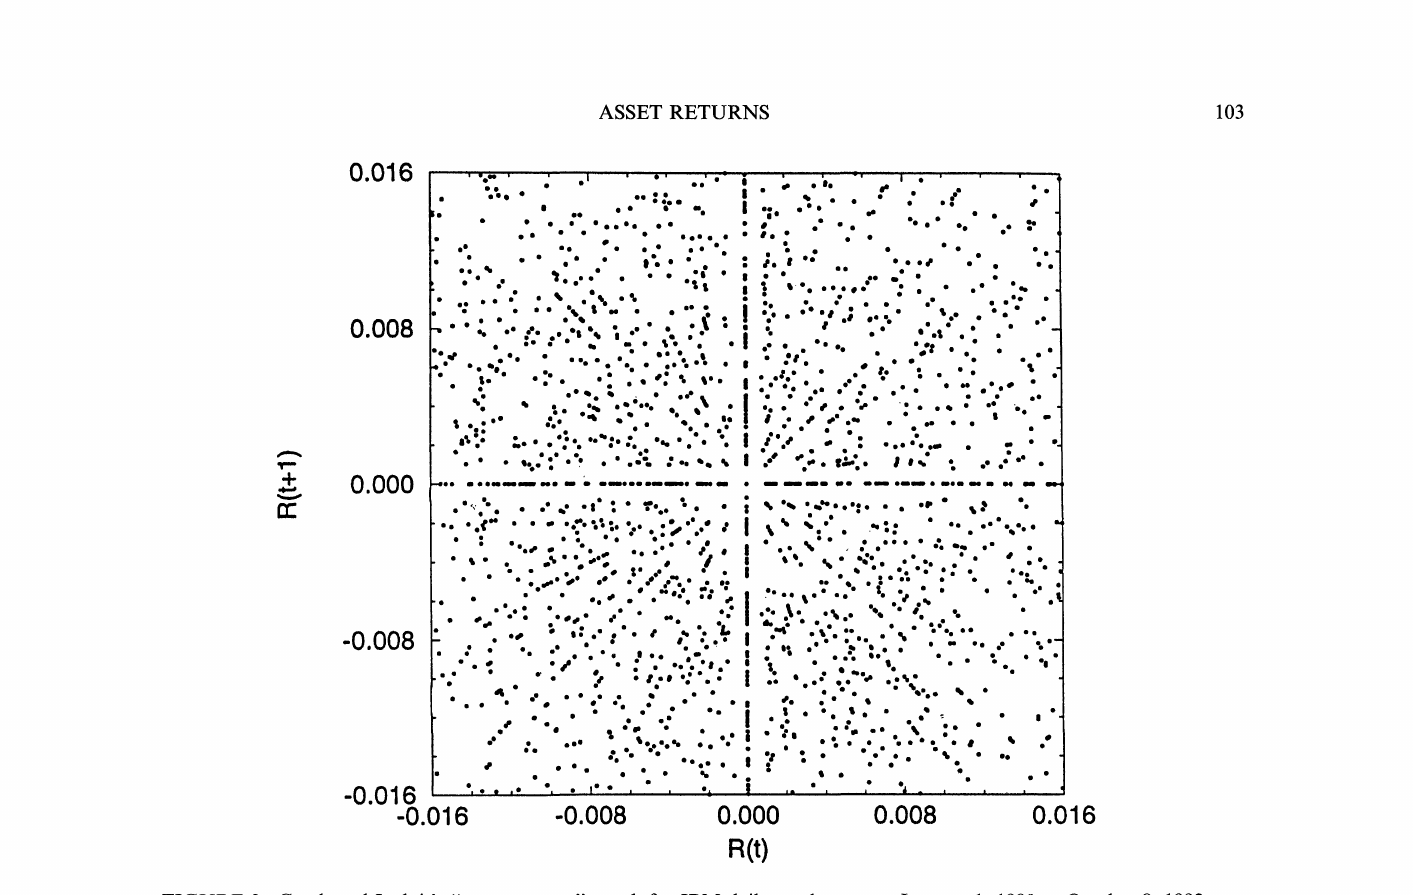
FIGURE 2 Crack and Ledit’s "compass rose" graph for IBM daily stock returns, January 1, 1980 to October 8,